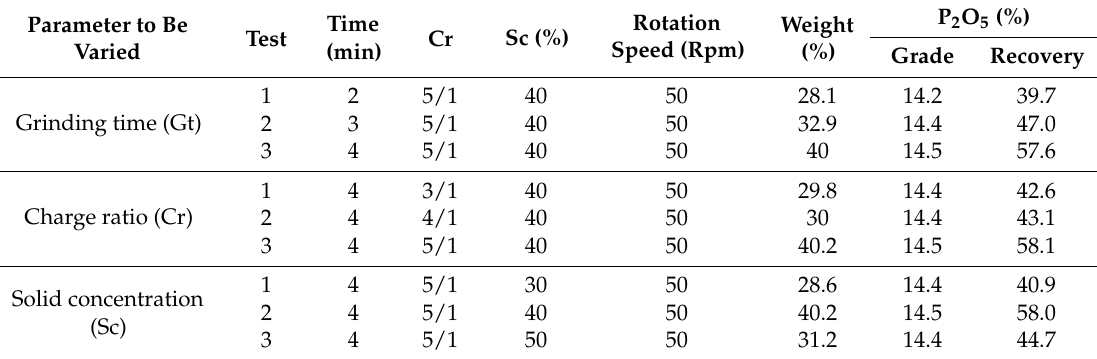
Table 8. Grinding tests results after variation of different parameters.